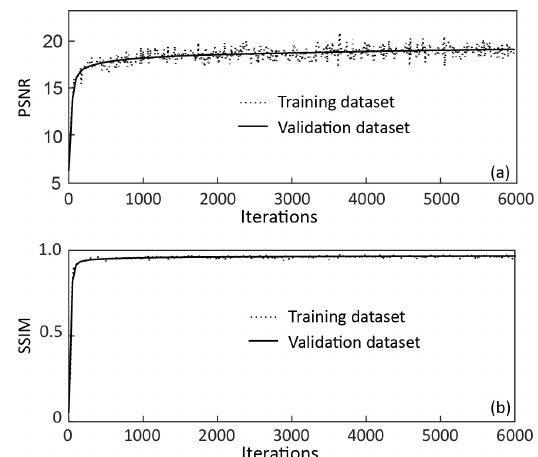
Figure 4. (a) PSNR and (b) SSIM values between paleovalley in- dex generated from SRCNN and DEM recorded for both training (60000 images) and validation (6000 images) datasets. For SRCNN training 50 images are used per